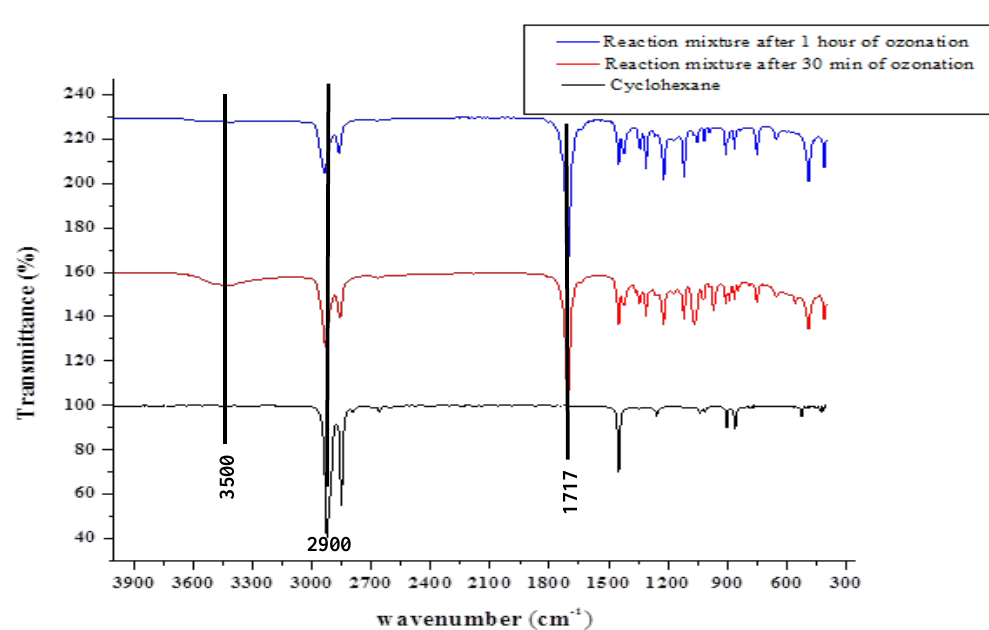
Figure 6. FT-IR spectra of 2.5% Mn / γ -Al 2 O 3 catalysed cyclohexane oxidation mixture at ambient reaction conditions and pH = 3 drawn after 30 min and 1 h of ozonation.